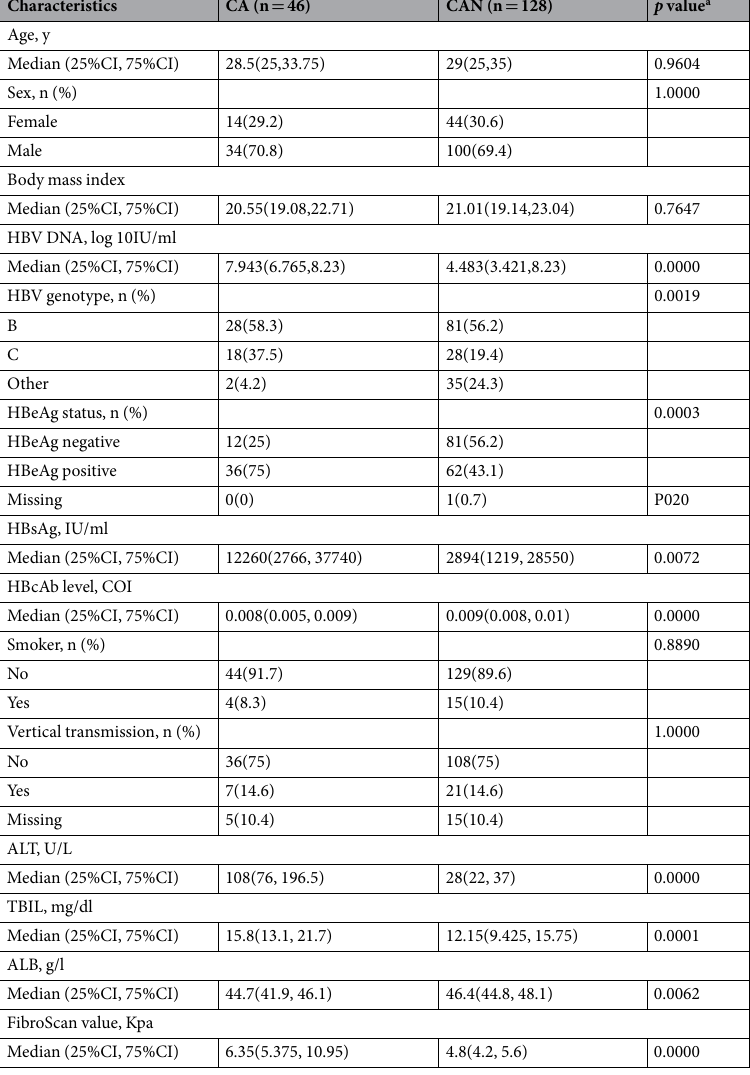
Table 1. Clinical-virology Characteristics of Patients Included in the Study. CI: Confidence interval, other: HBV genotype B and C mixed or indeterminate, COI: Cutoff index. The p-values were calculated using Mann- Whitney test for continuous variables and the χ 2 test for categorical